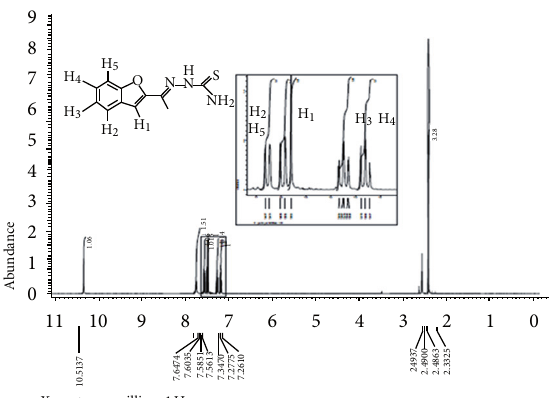
F 3: IR spectra of TSCL.